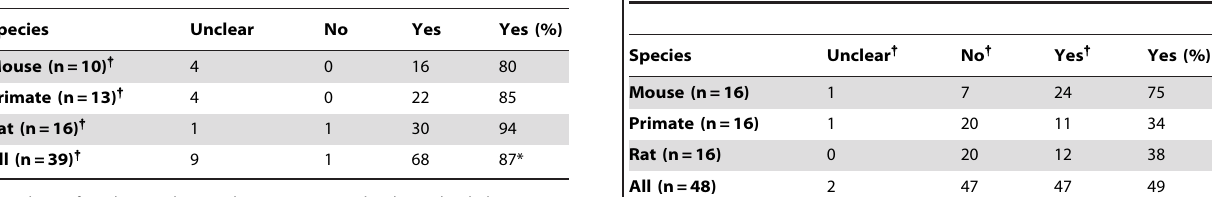
Table 20. Number of studies clearly stating the numbers of experimental units (e.g. individual animals or cages of animals) in all figures and tables.